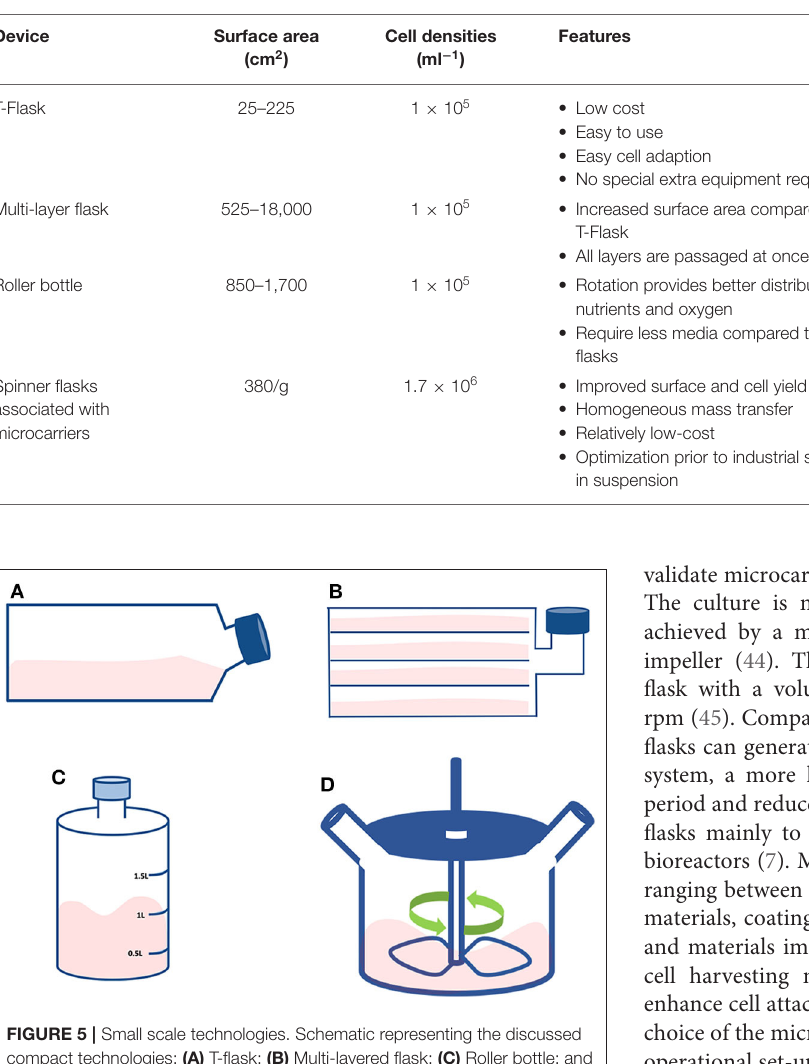
TABLE 1 | Table summarizing the advantages and limitations of the described small-scale systems.